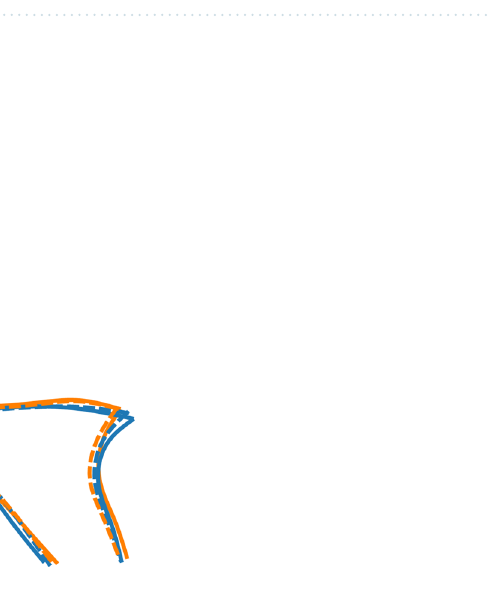
Figure 8. Shape space of the Mx region. Blue and light blue: control subjects; orange and light orange: βTh group. Circles: females; diamonds: males. Large markers show group means and standard deviation.